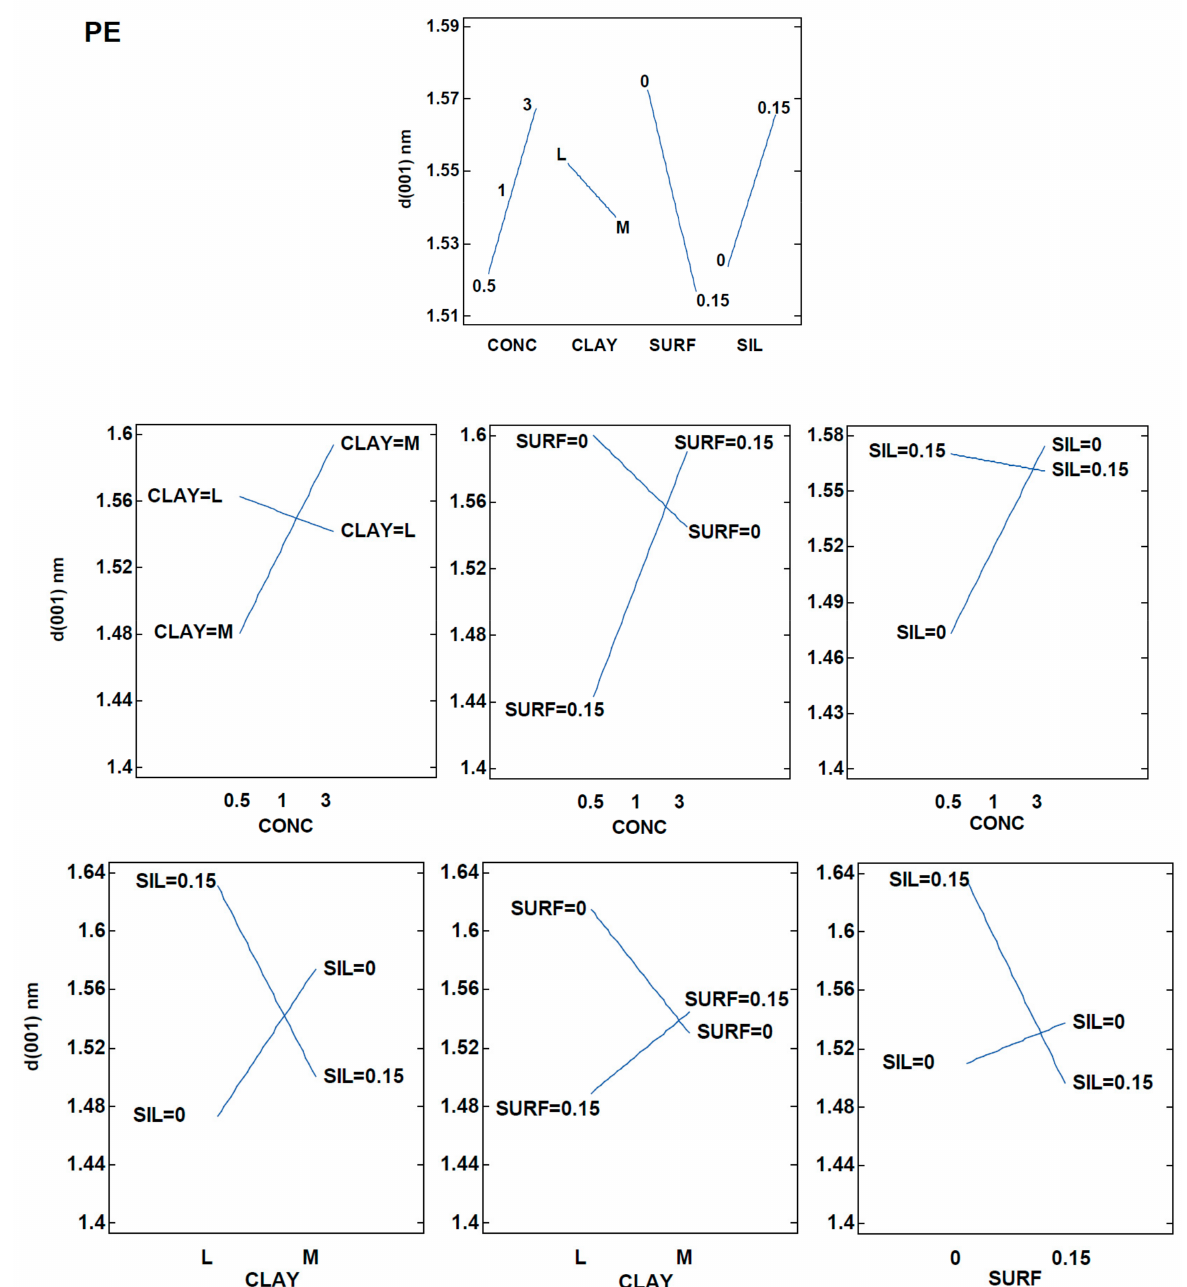
Figure 17. Main effects and interactions plots from the d(001) nm response in the PE